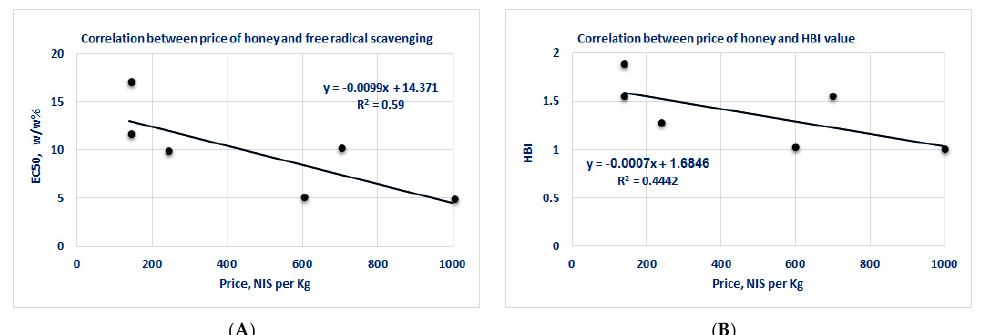
Table 2. Commercial honey types from Palestine, * prices, and antioxidant and antimicrobial activity. Each number is an average of four replications. HBI was calculated according to equation 1 based on both properties (antioxidant and antimicrobial activities).